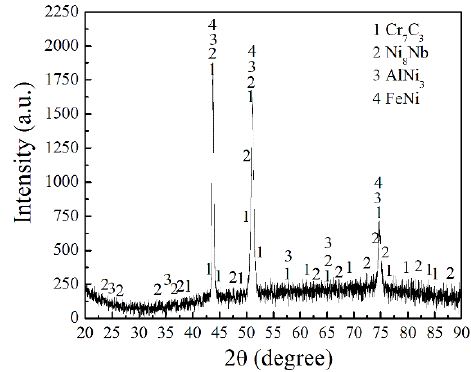
Figure 6. XRD patterns of the GH4169 substrate.